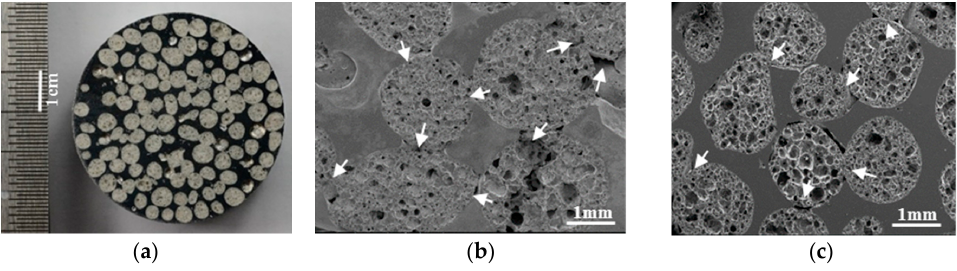
Figure 5. ( a ) EG-MSF cross-section; ( b ) SEM Images of StEG-MSF; and ( c ) SEM image of